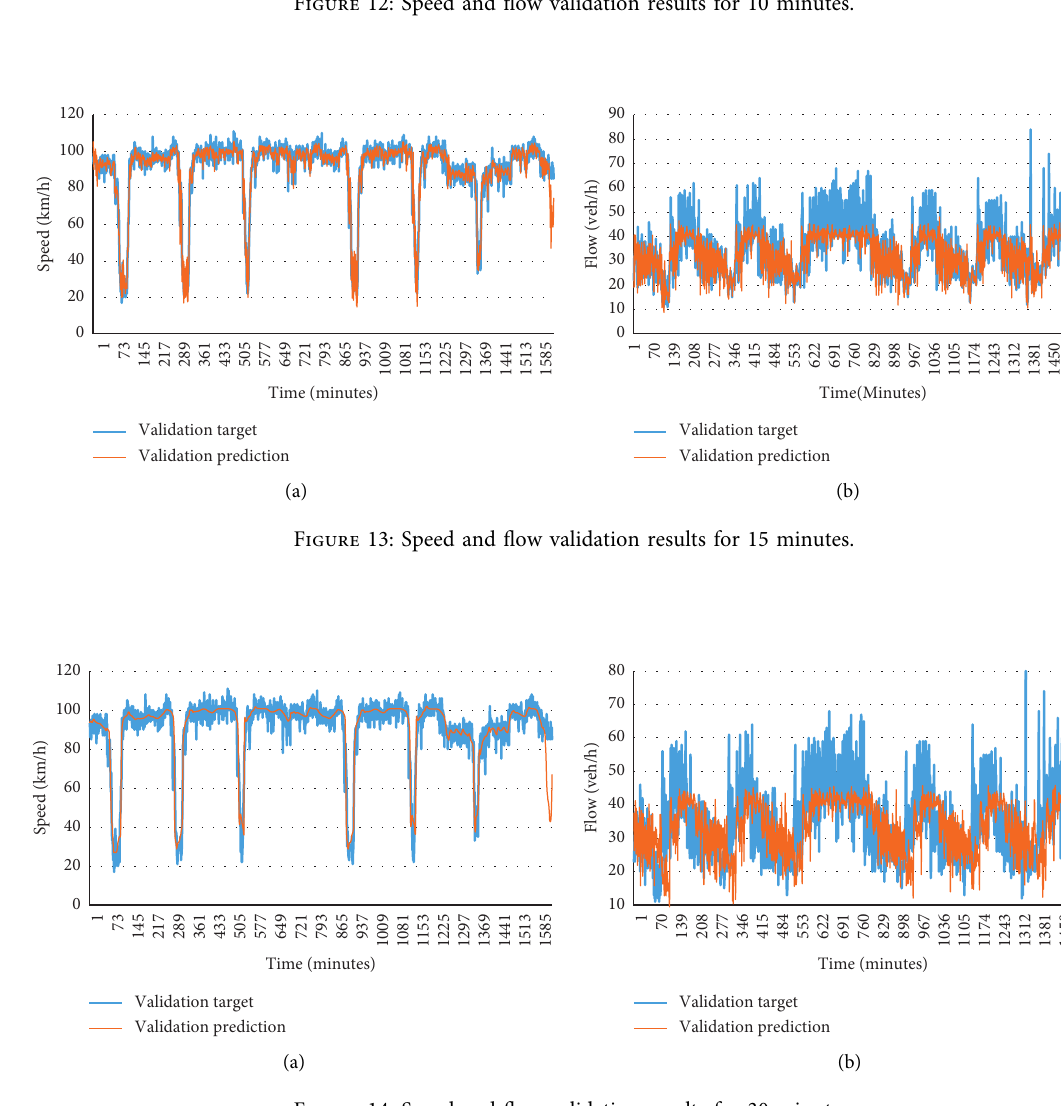
Figure 12: Speed and flow validation results for 10 minutes.